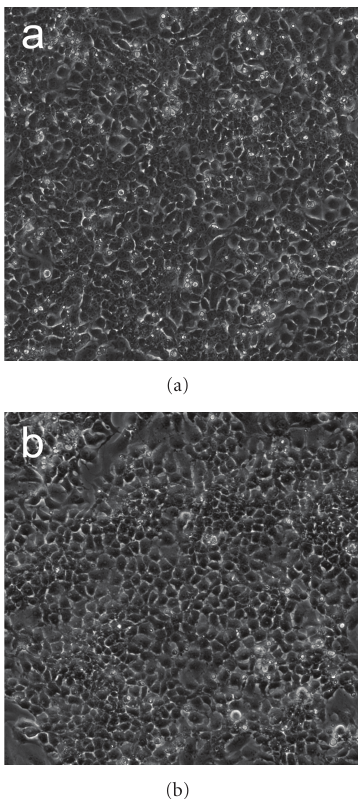
Figure 3: Marmoset iPS cells growing in feeder-free culture. (a) An iPS cell line derived by coinfection with four retroviruses (B8 cell line [25]). Cells are growing in defined xeno-free medium (Pluriton, Stemgent). (b) An iPS cell line derived by infection with a single retrovirus, encoding the OSKM reprogramming factors, illustrated in Figure